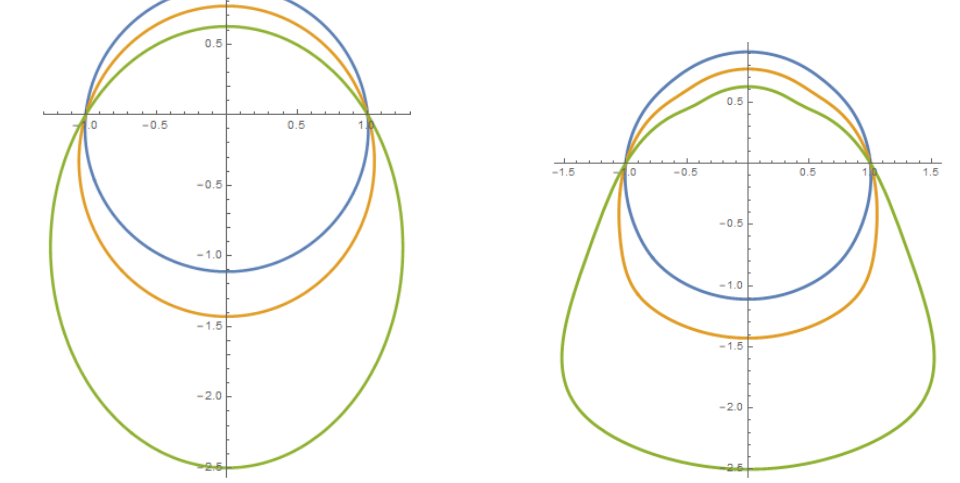
Figure 6: model class 4. left: contour curves of h for value 1 and p = 2, a = 0.1, 0.3, 0.6 , right: the same for p =